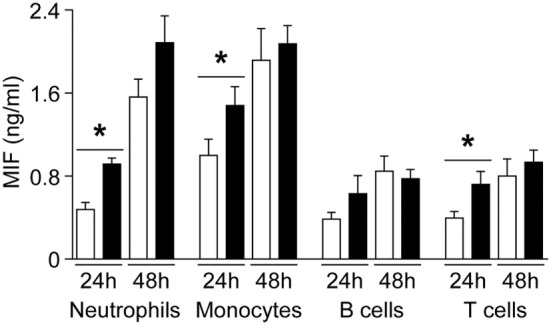
Macrophage migration inhibitory factor (MIF) secretion by newborn and adult leukocyte subsets. Neutrophils, monocytes, B cells, and T cells from healthy term newborns (white bars) and adult volunteers (black bars) were cultured in RPMI medium supplemented with 10% FCS. MIF levels were measured by enzyme-linked immunosorbent assay in supernatant collected at 24 and 48 h. Data represent means ± SEM of five to nine independent experiments performed in triplicates (*P < 0.05).